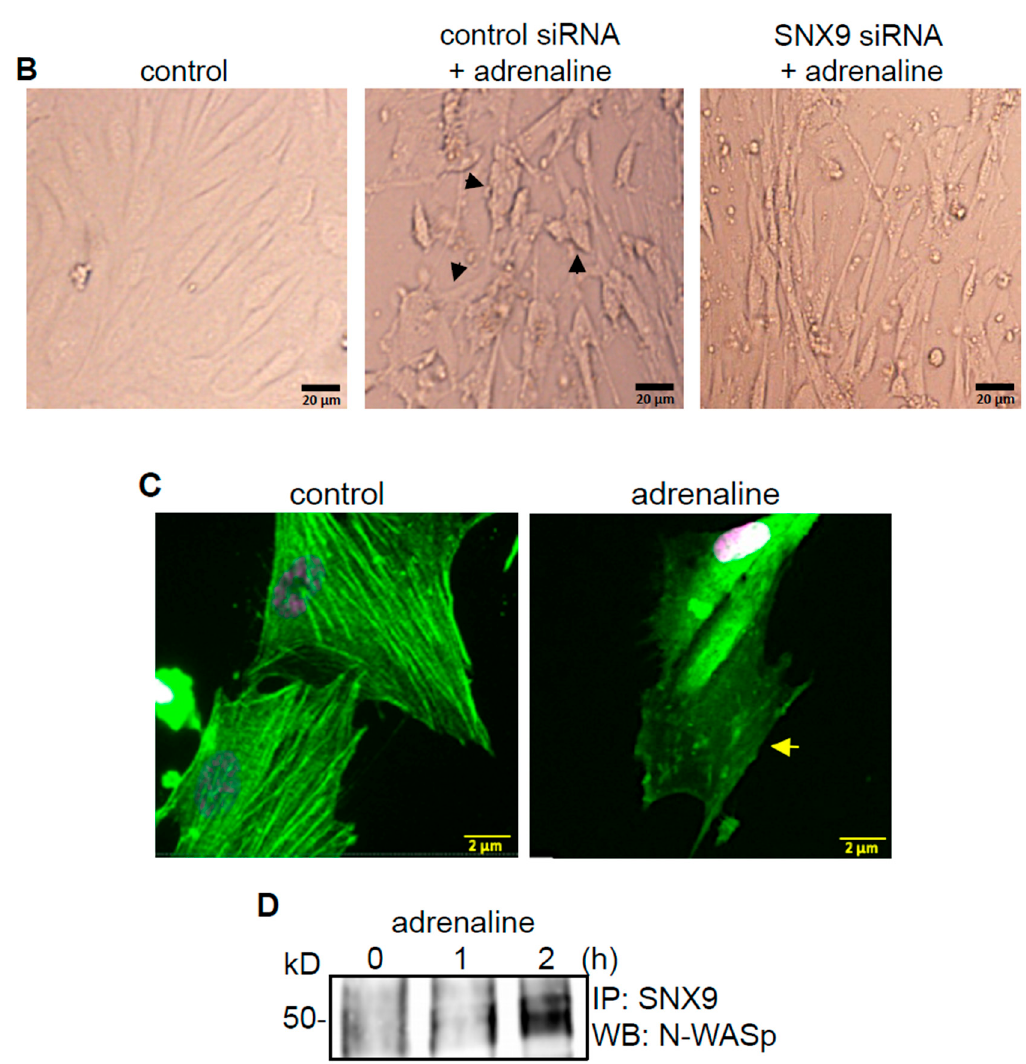
Figure 5. Studies of cultured human microvascular endothelial cells. ( A ) TEM images of the control cells and cells exhibiting the adrenaline-induced formation of endocytic vesicles. Cells were treated with adrenaline at 10 µ M for 4 h. Magnifications, × 13,000. ( B ) siRNA knockdown of SNX9 inhibits the adrenaline-induced bulge formation. Cells were treated with siRNA for 2 days and then with adrenaline at 10 µ M for 4 h. Cells were observed under light microscopy. Arrows indicate the bulge formation. Magnifications, × 400. ( C ) Immunofluorescence staining of actin in untreated control and cells treated with adrenaline (10 µ M; 4 h). The arrow indicates the reorganization of actin filaments. Magnifications, × 1000. ( D ) Adrenaline promotes SNX9–N-WASp interactions. Cells were treated with 10 µ M adrenaline for 0, 1 or 2 h. Cell lysates were subjected to immunoprecipitation (IP) with mouse SNX9 IgG followed by Western blotting (WB) with rabbit N-WASp IgG.